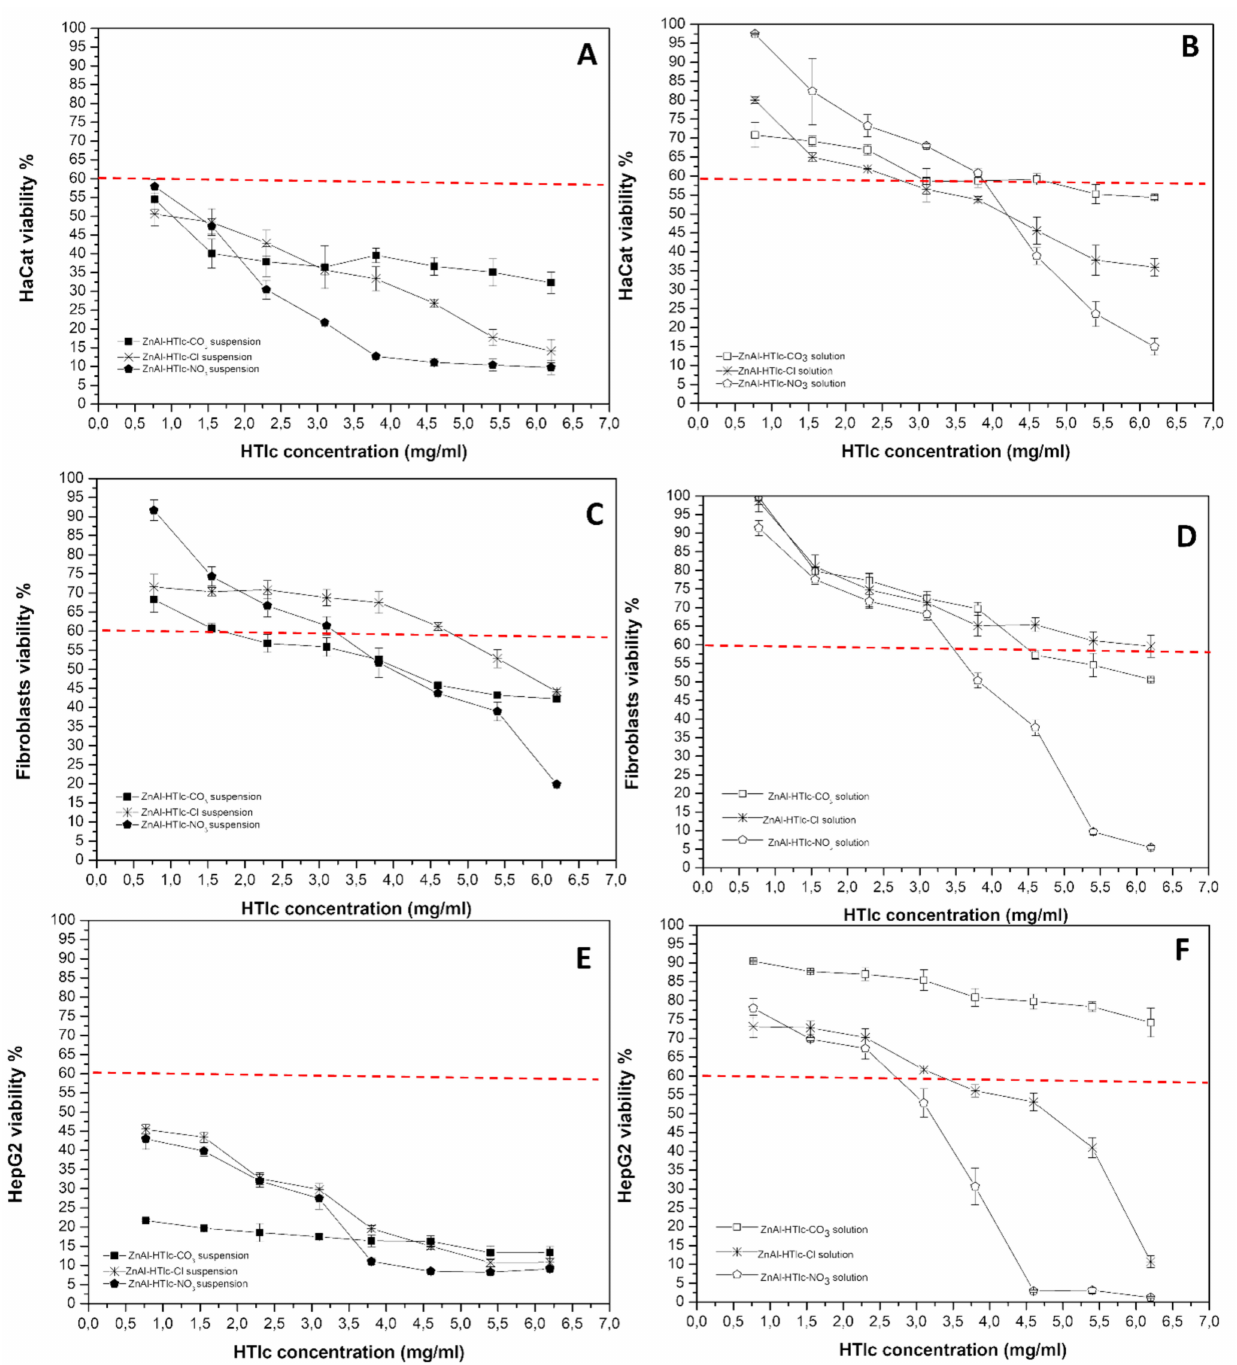
Figure 6. Viability of HaCat cells incubated with ZnAl-HTlc suspensions ( A ) and supernatants ( B ); viability of fibroblasts incubated with ZnAl-HTlc suspensions ( C ) and supernatants ( D ); viability of HepG2 cells incubated with ZnAl-HTlc suspensions ( E ) and supernatants ( F ). The percentage of viable cells with respect to the control was reported as the mean ± SD of five independent experiments. Dotted lines indicate 60% cell